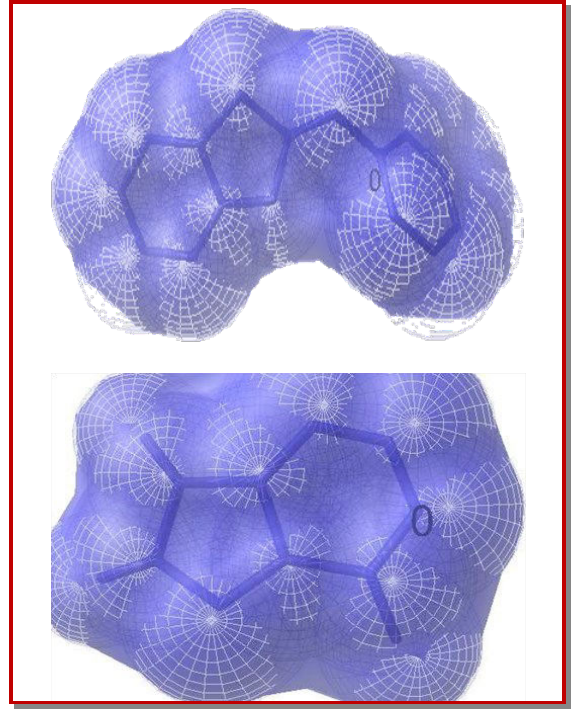
Figure 3: Docked pose of xanthine oxidase enzyme (3BDJ) with 2 benzylcoumarin and